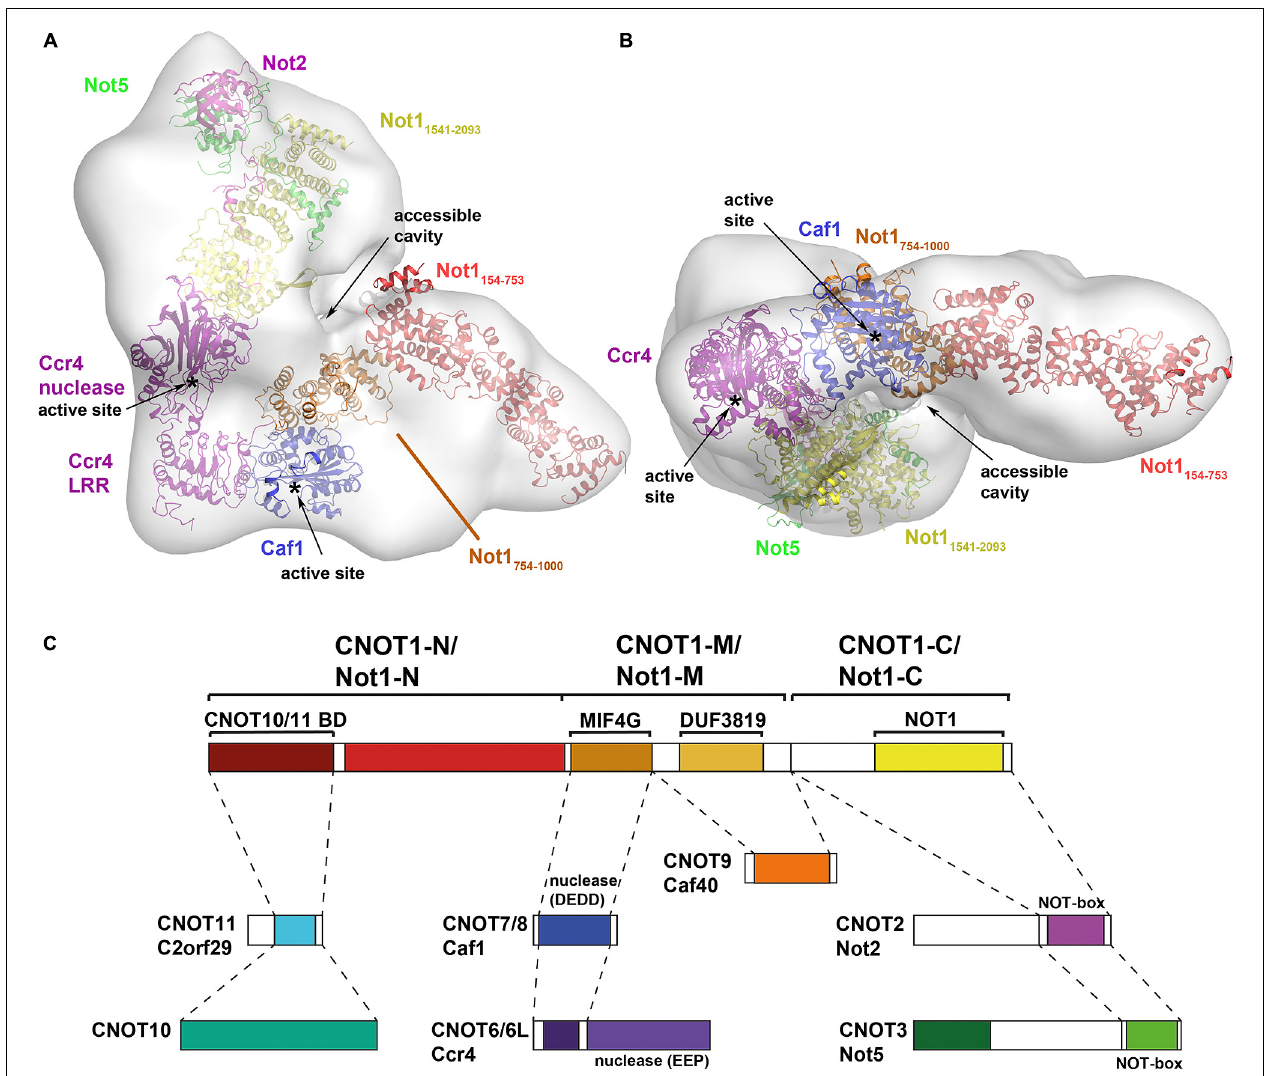
N-terminal domain of Not1 (PDB ID: 4B89); Not1–Ccr4–Caf1 (PDB ID: 4B8C); CNOT6L nuclease domain (PDB ID: 3NGQ); Not1–Not2–Not3 (PDB ID: 4BY6). The active sites of Ccr4 and Caf1 and the accessible cavity in the CCR4–NOT complex are labeled. (C) Map of the interactions in the CCR4–NOT complex (adapted from Bawankar etal., 2013). Subunits or domains are colored according to structures in